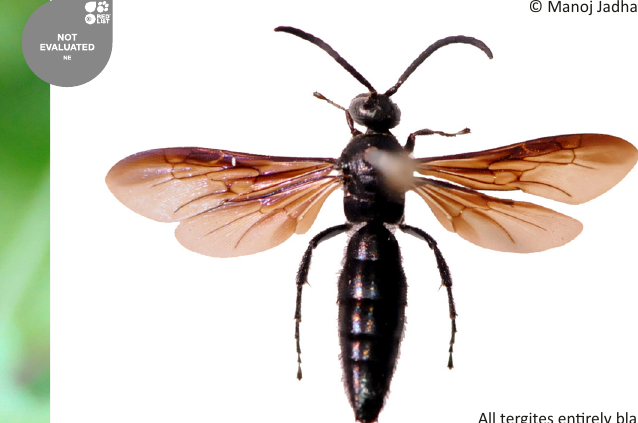
All tergites entirely black